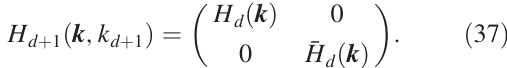
FIG. 6. Layer-stacking construction of higher-order topological phases: (a) A ( d þ 1 )-dimensional crystal is constructed out of alternating d -dimensional layers with opposite topological num- bers. The unit cell consisting of two such layers is not mapped to itself under the (anti)symmetry operation S , which inverts the coordinate x in the stacking direction. (b) The unit cell may be d þ 1 redefined, so that it is mapped to itself under S . This redefinition of the unit cell involves splitting the odd layers into two parts that are mapped onto each other under S , eventually after adding topological trivial